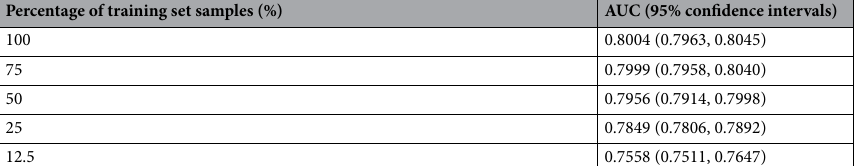
Percentage of training set samples